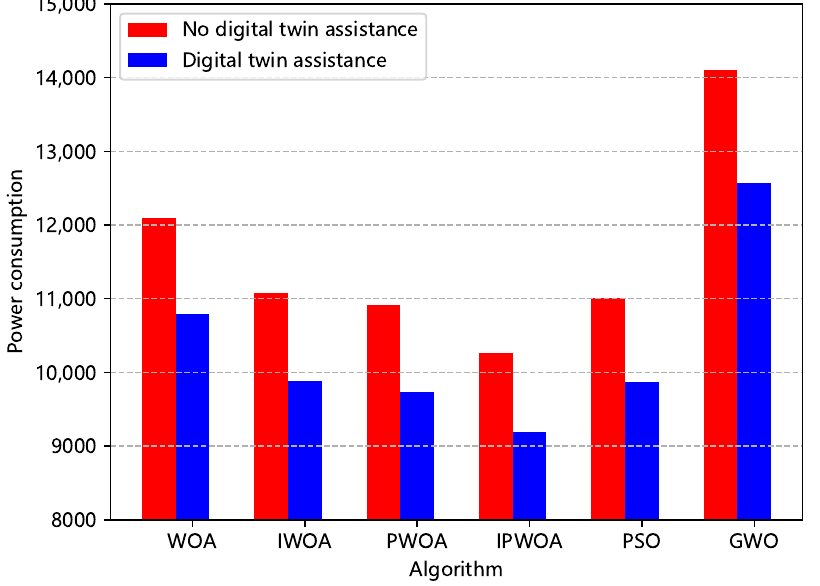
Figure 9. Comparison of the impacts of a DT on the edge-computing power consumption. The re- source device power consumption was generated by the optimal allocation scheme of each